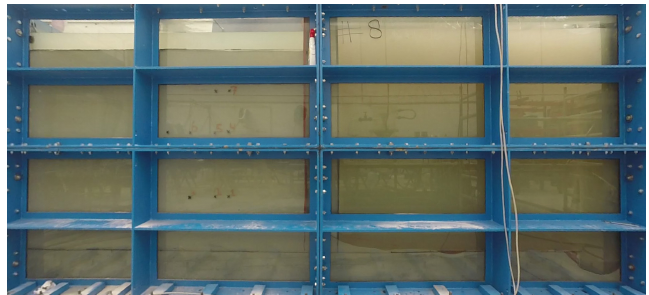
Figure 6. Front side of the breaching tank just before Experiment 8. The view is partially obstructed by the vertical steel bars in the middle of the tank.